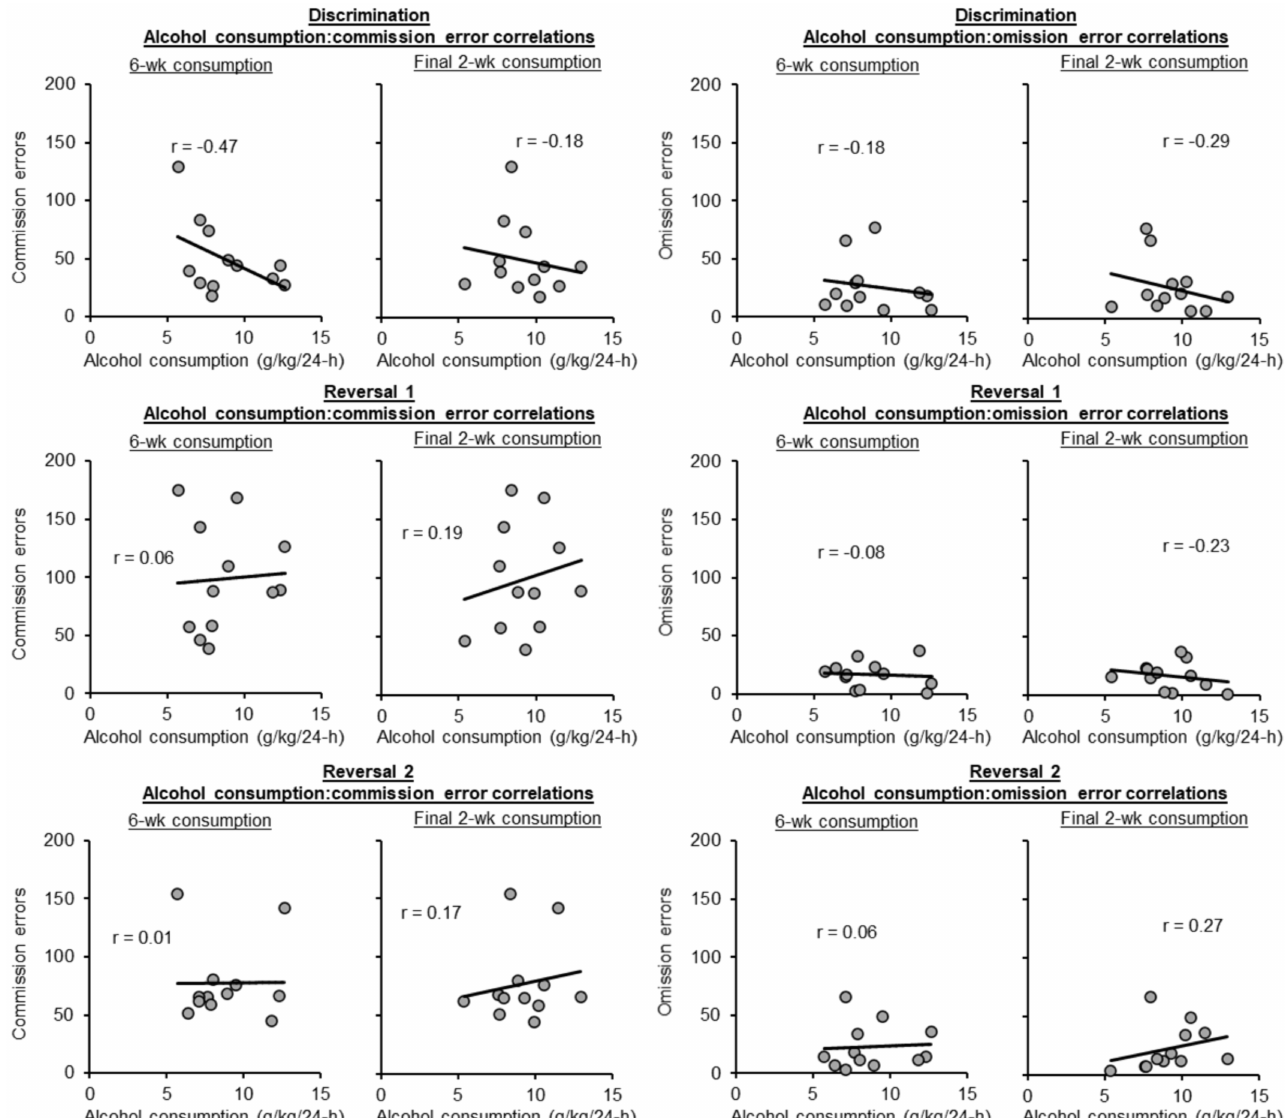
Figure 2. Correlations between alcohol consumption and discrimination/reversal learning errors. The top row represents errors during the discrimination phase, the middle row represents errors during the first reversal phase, and the bottom row represents error during the second reversal